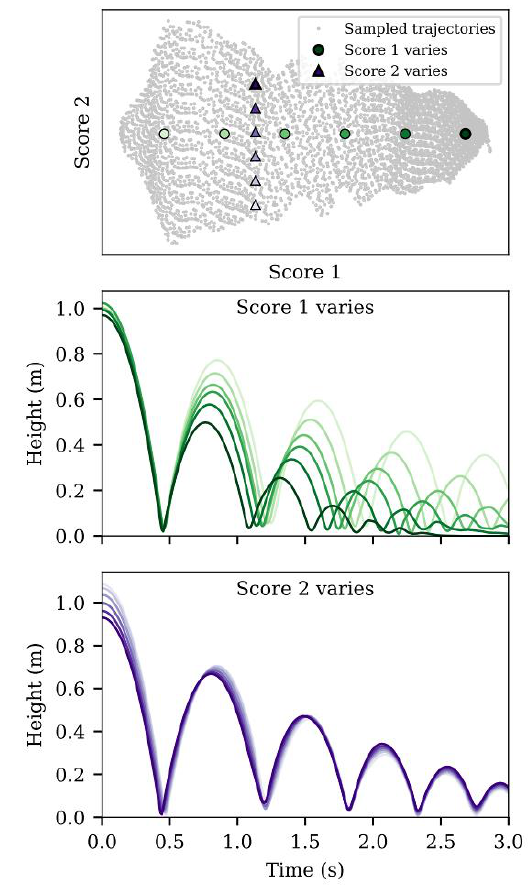
Figure 5. Distributions of time maximum absolute error, relative error and RMSE between test trajectories and reconstructions with increasing number of principal components (left), and reconstructions by a 1 and 2 dimensional AAM (right) with both the coefficient of restitution and initial height varying. Same graphical convention as in Figure 3.